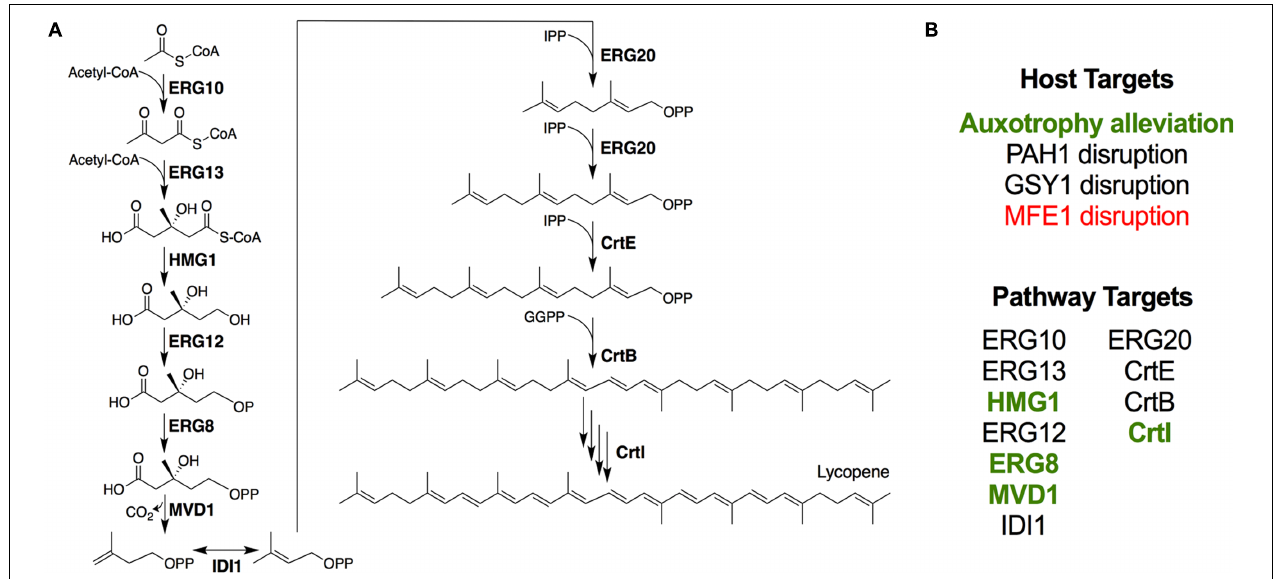
FIGURE 1 | Engineering lycopene biosynthesis in Y. lipolytica . (A) Schematic of the lycopene biosynthetic pathway from acetyl-CoA. For simplicity, cofactors and ATP consumption is not shown. (B) Summary of strategies attempted in this work. Items shown in green enhanced lycopene yield, while items shown in red reduced lycopene